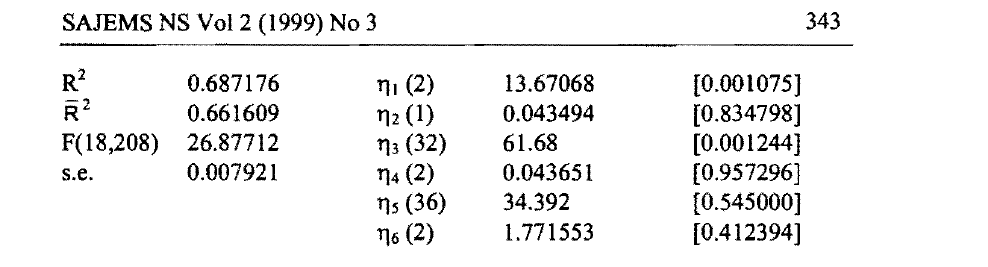
Cointegration correction: Dependent variable: In(R150 t)